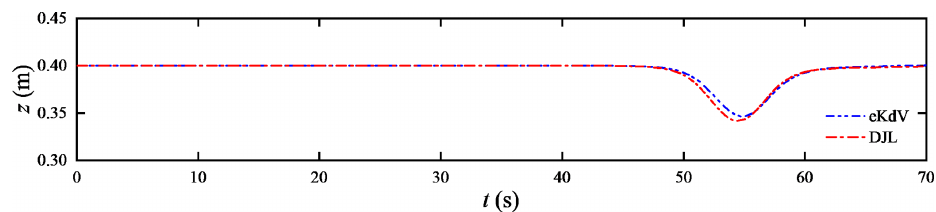
Figure 3. Time series of the interface displacement. The probe was 10m away from the initial